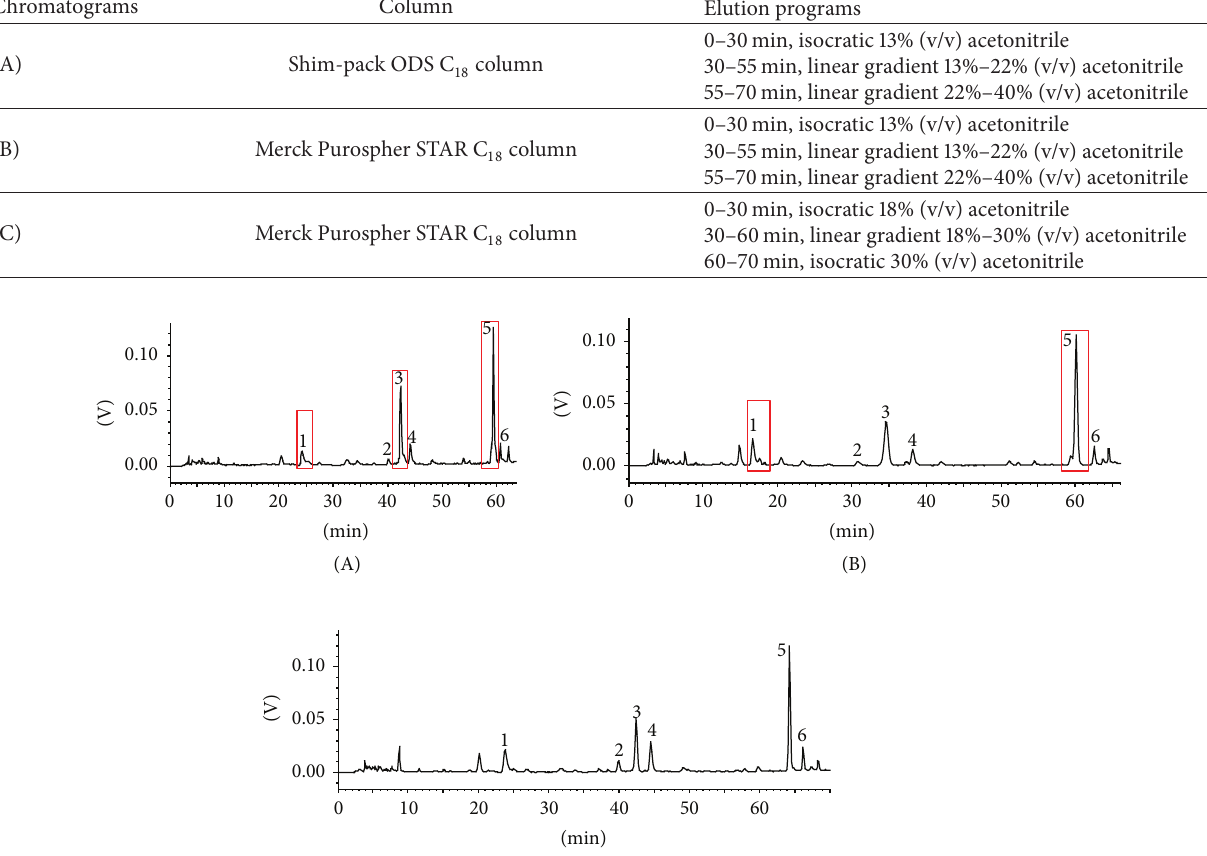
Figure 2: HPLC chromatograms of the sample solution under different conditions (1: luteolin-7- O - 𝛽 -D-glucuronide; 2: apigenin-7- O - 𝛽 -D- glucuronide; 3: diosmetin-7- O - 𝛽 -D-glucuronide; 4: acacetin-7- O - 𝛽 -D-glucuronide; 5: tilianin; 6: rosmarinic